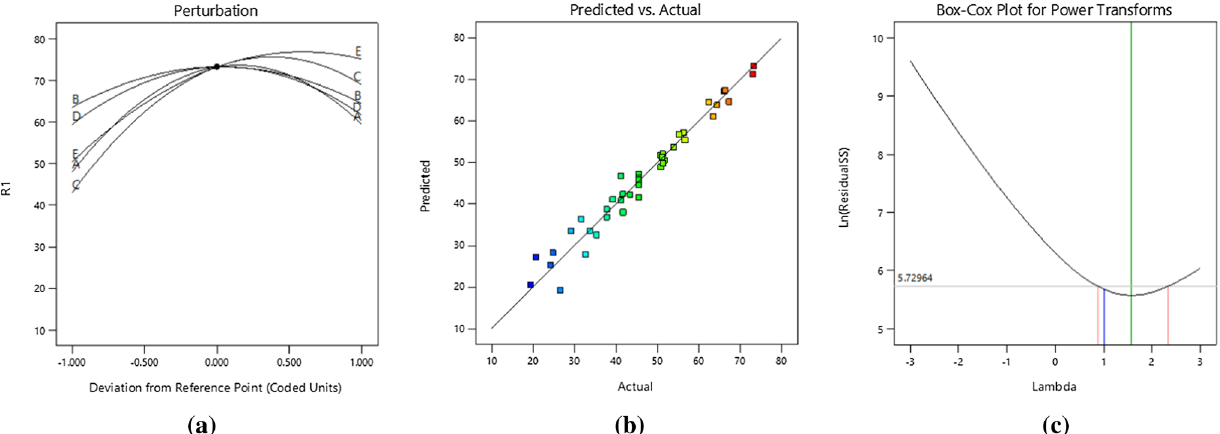
Fig. 4 Diagnostic plots generated during ANOVA. a Relation between the actual and predicted values; b perturbation plot of all the process parameters; and c Box-Cox plot for melanoidin removal (%) using the prepared activated carbon